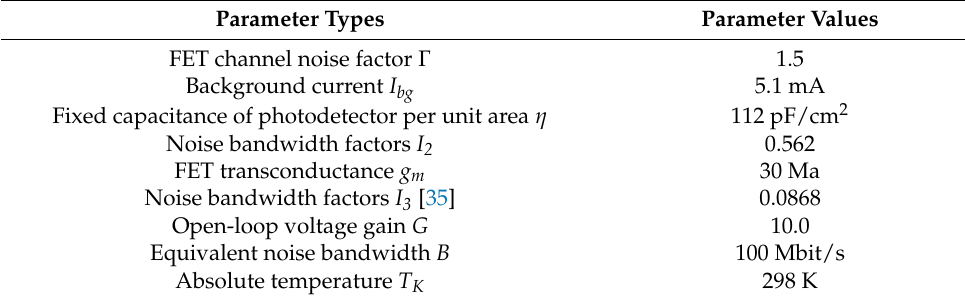
Table 11. The simulation and design parameters of the indoor VLC system.